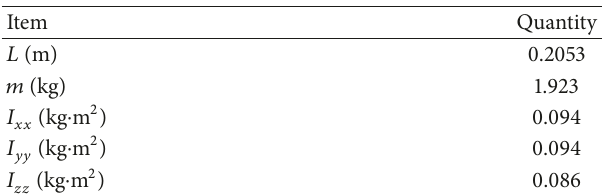
Table 1: Physical